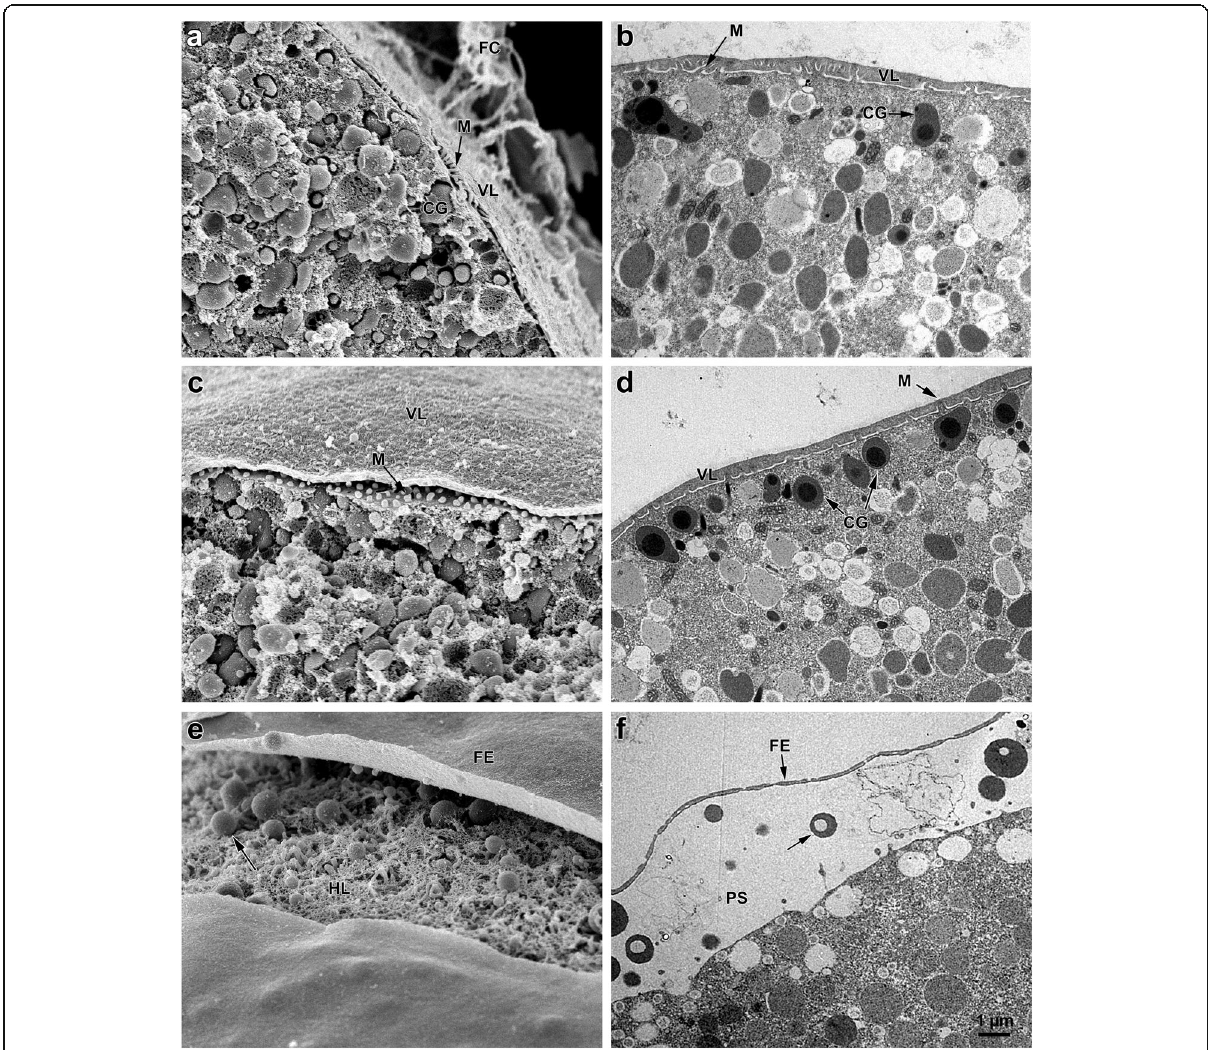
Fig. 3 Scanning and transmission electron micrographs of immature oocytes and mature eggs before and after fertilization. a A fractured immature oocyte showing microvilli (M) beneath the vitelline layer (VL) and organelles in the cytoplasm. b Microvilli project from the oocyte ’ s surface into the VL. Cortical granules (CG). c A mature egg treated with 1-MA for 50 min. At this optimal period of fertilizability, microvilli (M) beneath the VL are shorter. d The ultrastructure of a mature egg stimulated with 1-MA for 50 min shows shortened microvilli (M) and cortical granules (CG) positioned beneath the egg surface. e Fertilization envelope (FE) elevation in a mature egg 3 min after insemination showing the spherical bodies (arrow) in the perivitelline space following CG exocytosis. Hyaline layer (HL). f The electron-dense spherical bodies of the CG in the egg surface before fertilization in D are now seen in the perivitelline space (PS) upon insemination. Same magnification in all